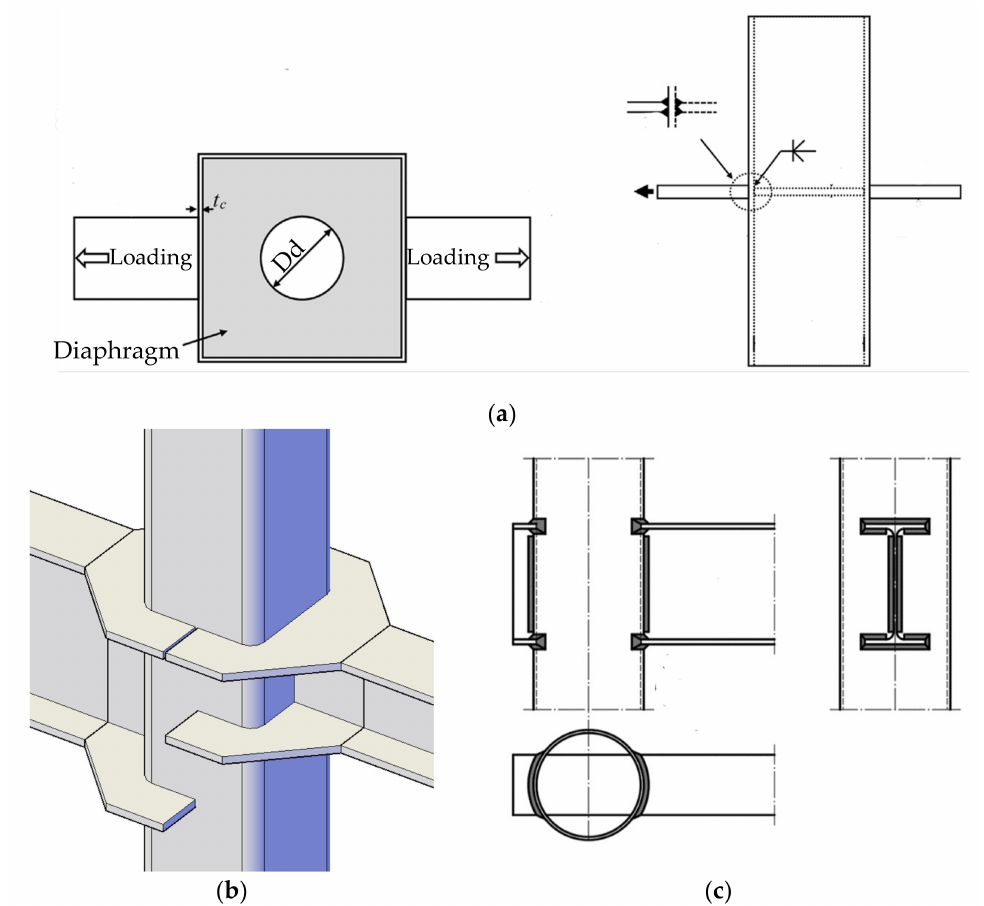
Figure 1. Typical connection for concrete-filled steel tubular column (CFST) structures: ( a ) Connection with the internal-diaphragm; ( b ) Connection with the outer-diaphragm; ( c ) Connection with the